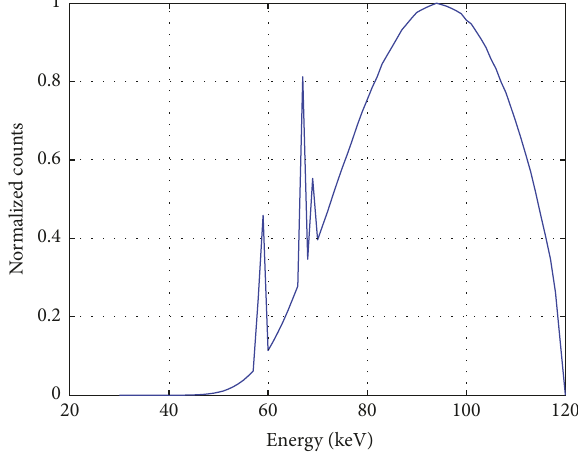
Figure 2: Spectrum of incident polychromatic X-ray source.